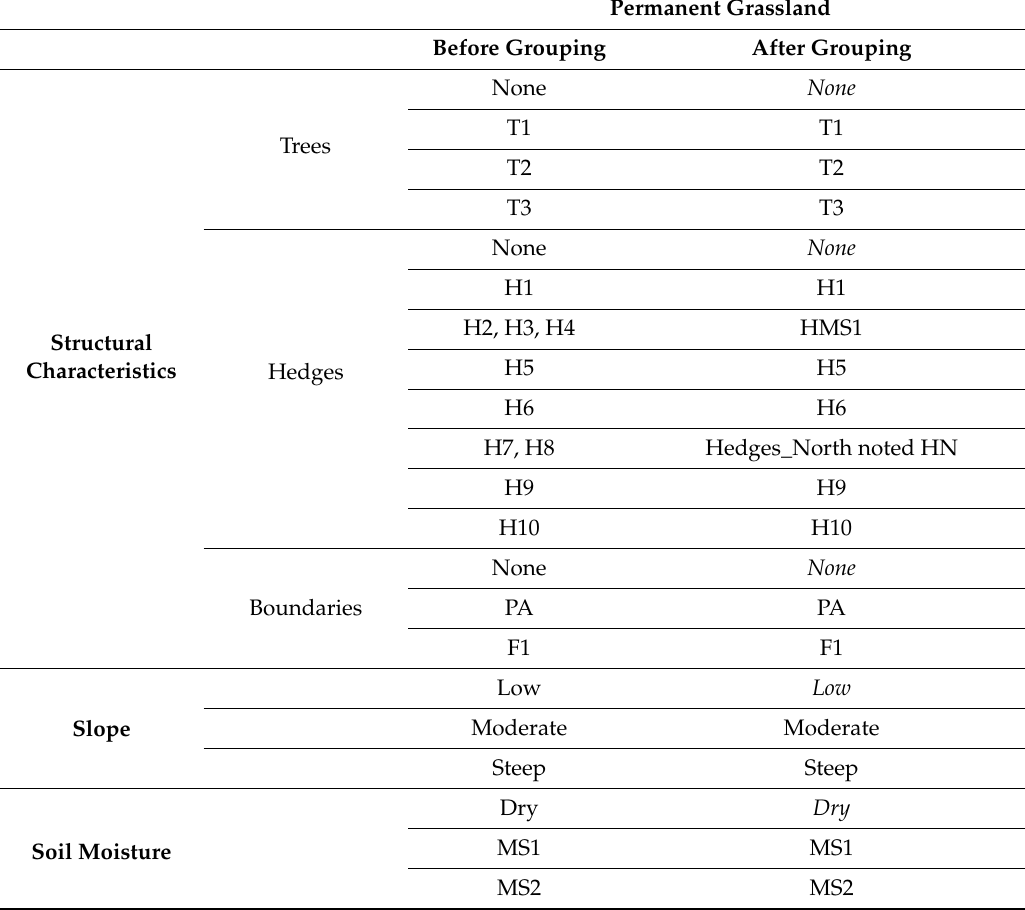
Table 1. Pasture characteristics before and after the grouping carried out to reduce the correlation between characteristics for the permanent grassland and the temporary